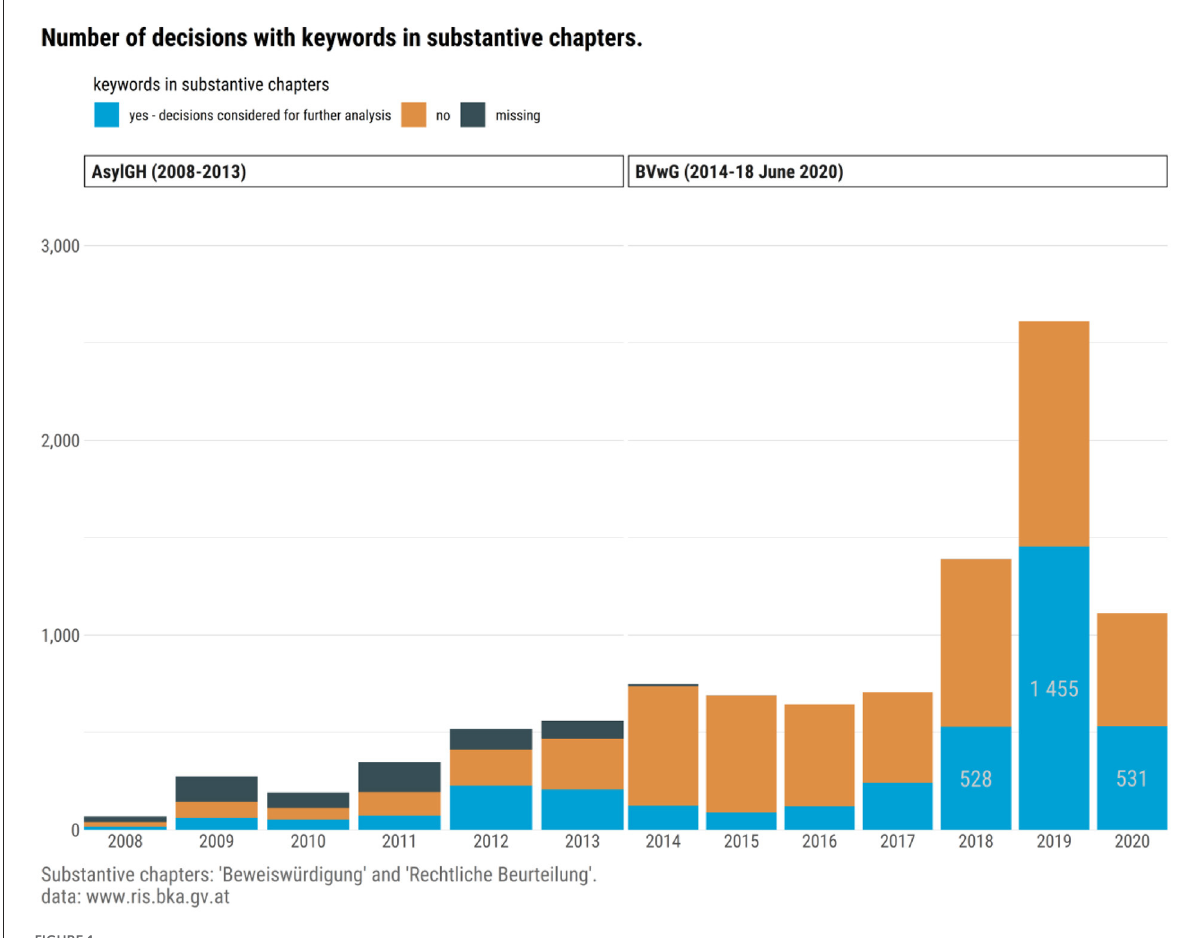
FIGURE1 Keywords in substantive chapters per year until 18 June 2020 11